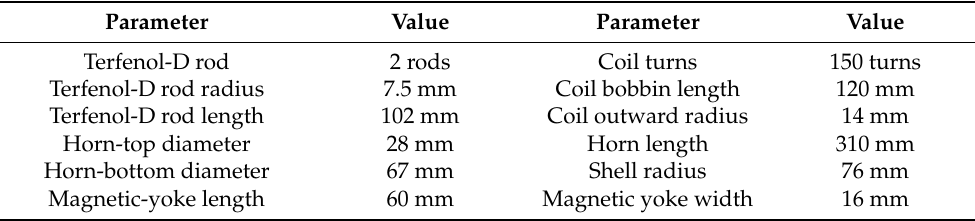
Figure 6. The prototype of the GMT. Table 2. Main Materials and Parameters of the GMT.